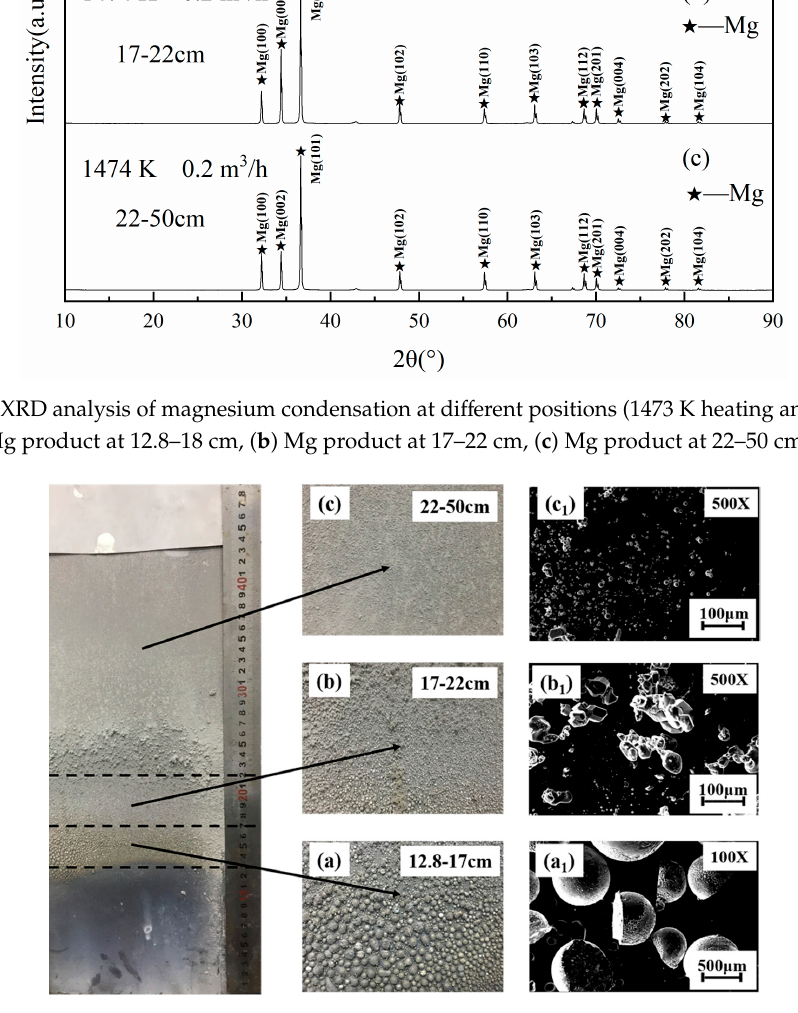
Figure 9. Macroscopic phenomenon of Mg vapor condensation in different condensation zones (1473 K heating and 0.2 m 3 /h Ar): ( a ) Mg product at 12.8–18 cm, ( b ) Mg product at 17–22 cm, ( c ) Mg product at 22–50 cm, ( a 1 ) SEM image of Mg product at 12.8–18 cm, ( b 1 ) SEM image of Mg product at 17–22 cm, ( c 1 ) SEM image of Mg product at 22–50 cm. XRD images of different condensation zones at an Ar flow rate of 0.2 m 3 /h and heat source Figure 9. The crystalline morphology of droplet magnesium or powder magnesium had high purity. Magnesium condensation product had a preference for the (101) orientation than others. The preferred orientation did not change with the condensation temperature, which was different from the Xiong’s XRD results [25]. Magnesium vapor condensed in vacuum directly by Xiong’s experiment, while our experiment was carried out in argon. In our experiment, we considered that it was beneficial to the (101) orientation of magnesium condensation products in the flow of argon of a single direction flow of mixed